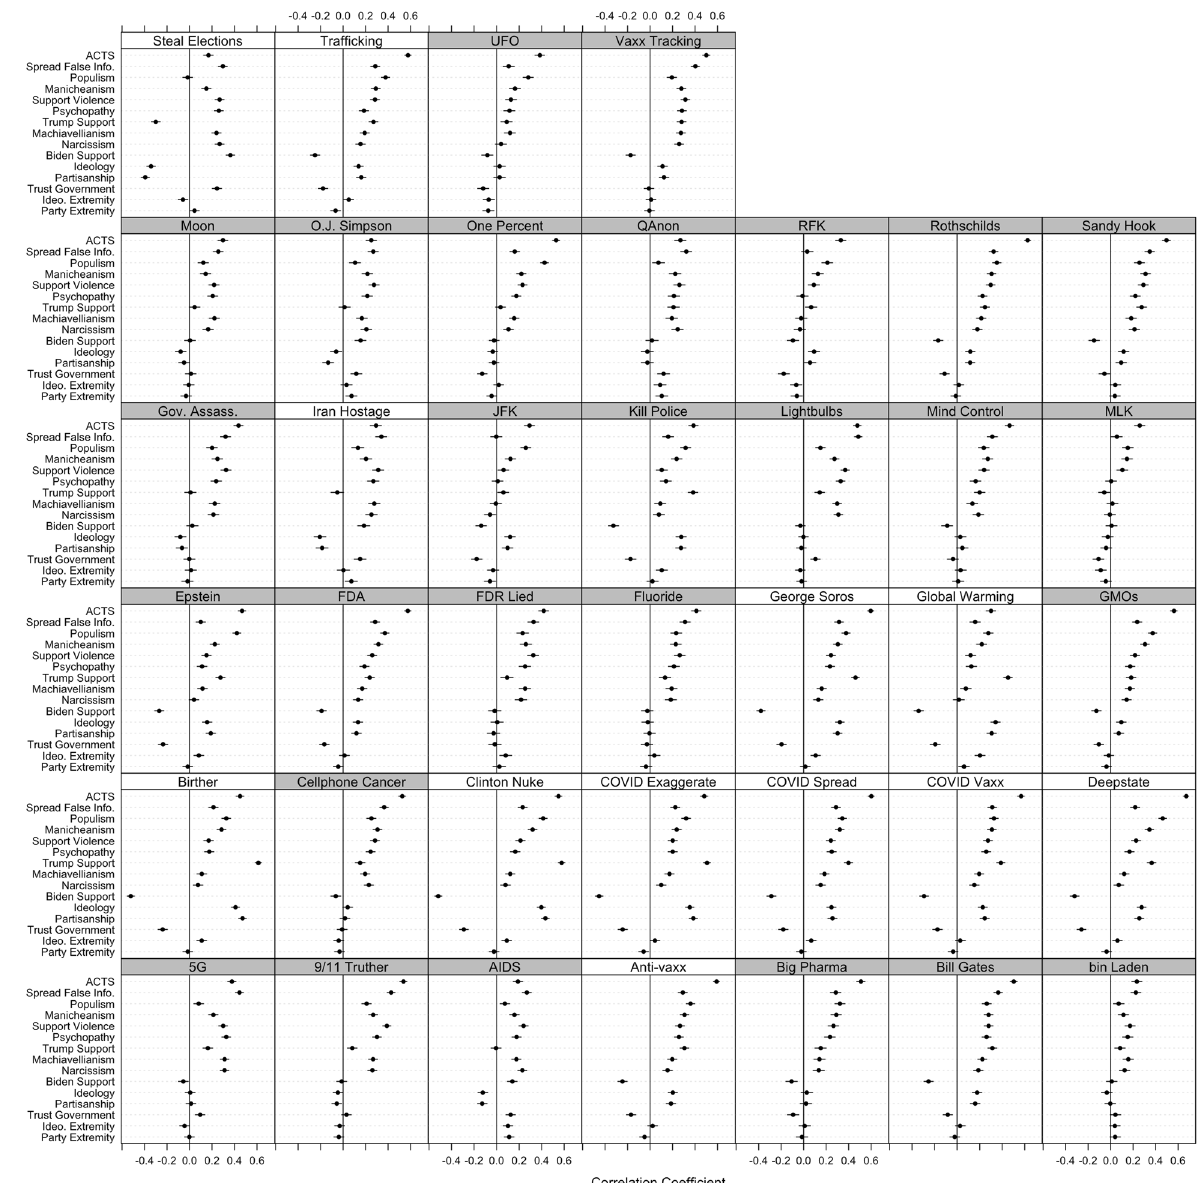
Figure 4. Pearson correlations between each psychological and political characteristic and each of 39 conspiracy theory beliefs. Partisan/ideological conspiracy theories have white labels, non-partisan/ideological conspiracy theories have gray labels. Horizontal black bars are 95% confidence